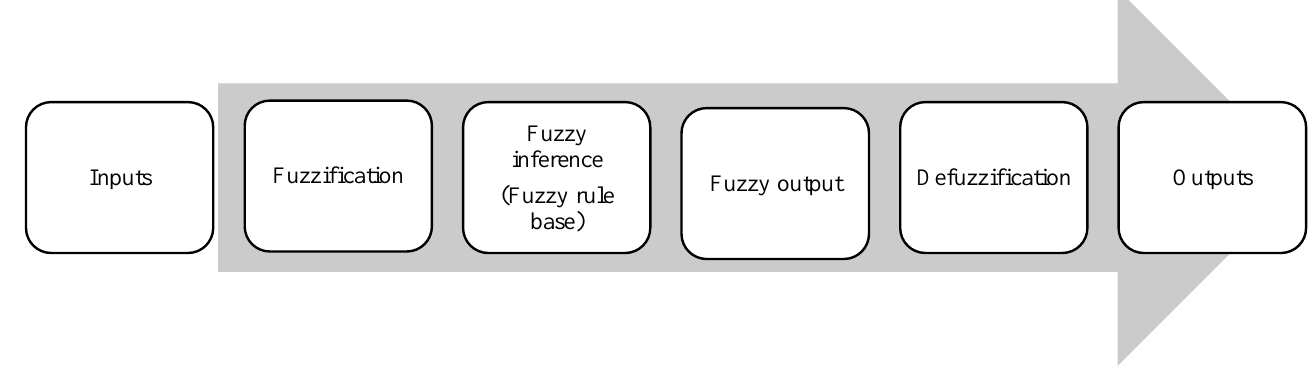
Figure 1. Structure of FMEA Based on Fuzzy